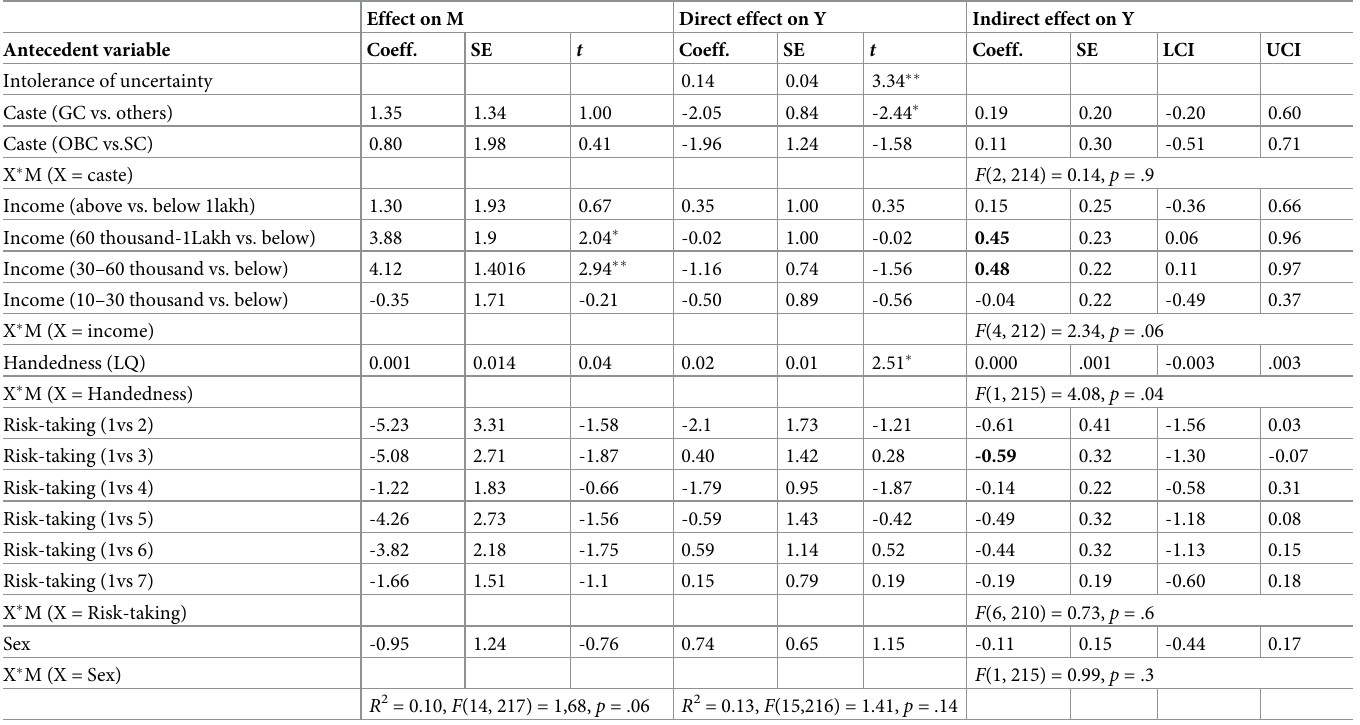
Table 13. The effects (direct and indirect effect) of antecedent and mediation (general IU) variables on believing in the community